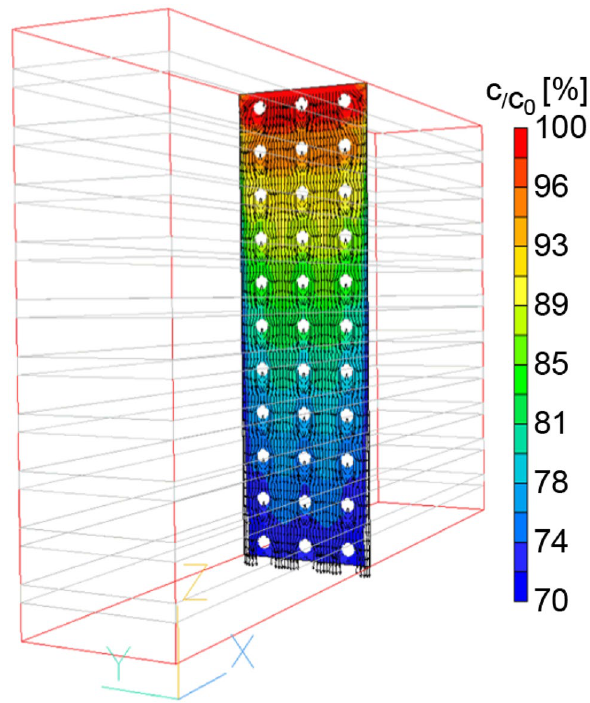
Fig. 3 CFD simulation results for prototype B. Displayed here is a y–z-section of the simulation space shown in Fig. S4 of Online Resource 1. All concentrations are given as percentages relative to the uptake